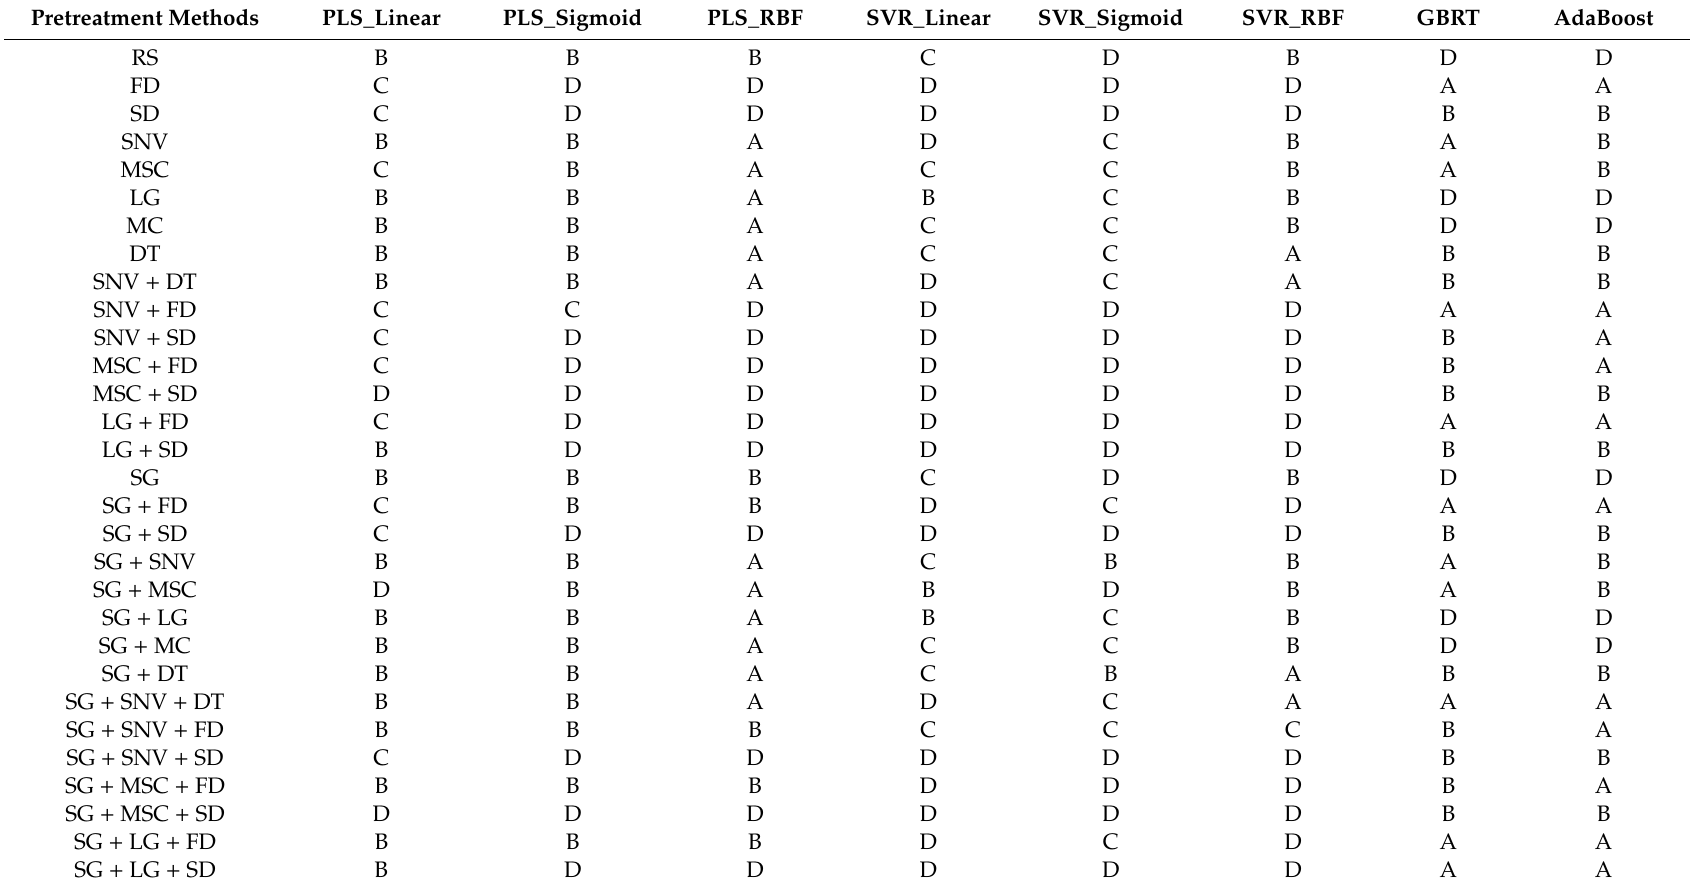
Table 4. RPD level of regression models with di ff erent pretreatment